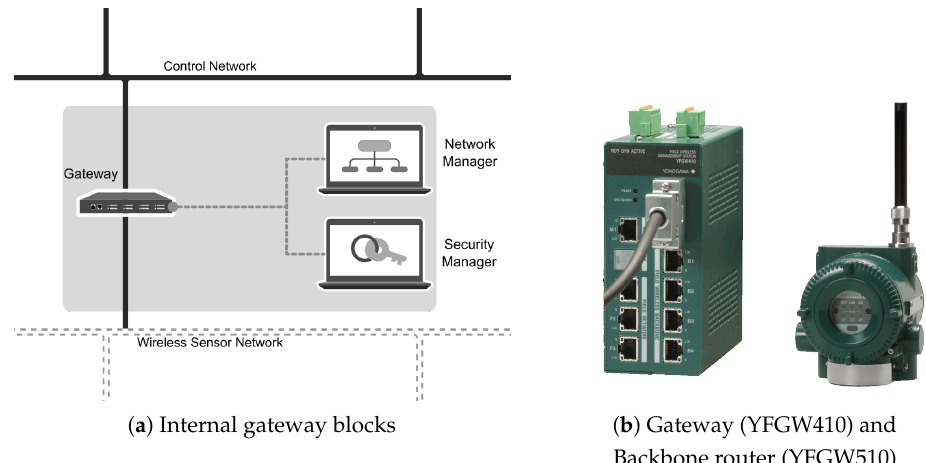
Figure 2. Gateway, network manager, security manager and backbone